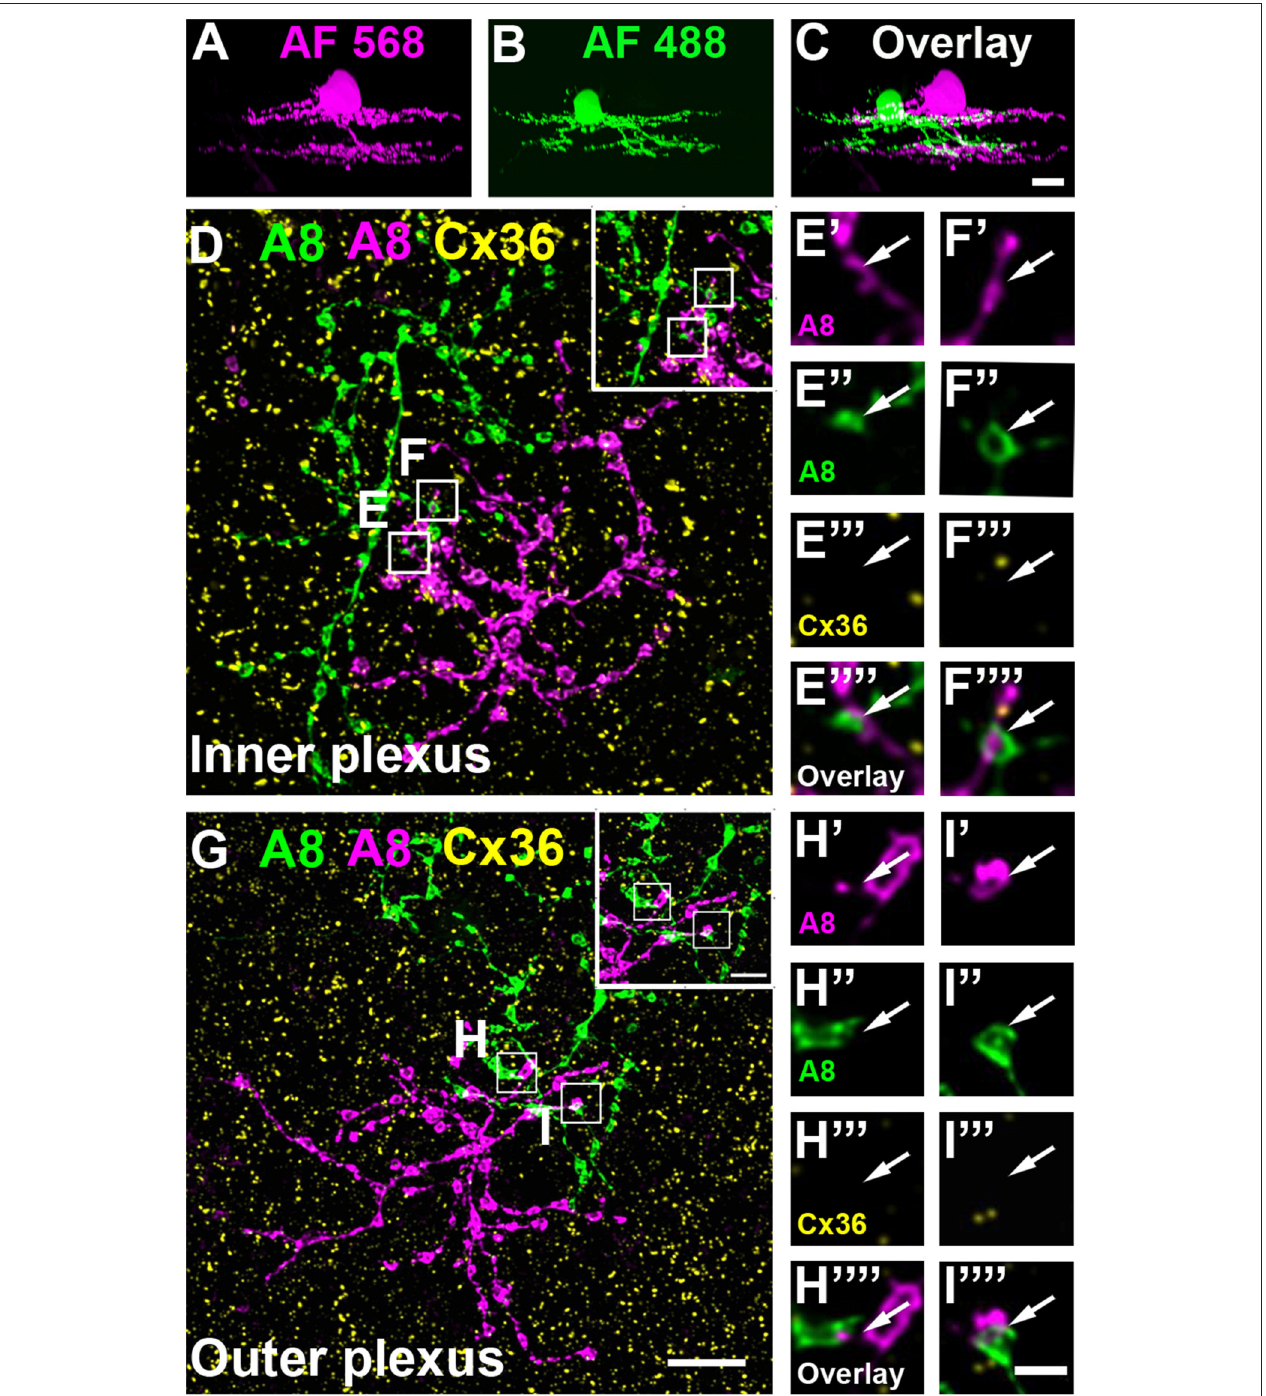
FIGURE 3 | A8 amacrine cells do not contact other A8 cells via Cx36. (A–C) XZ rotation of two A8 cells injected with Alexa Fluor 568 (A) and 488 (B) with overlapping dendrites (C) . (D–I””) Maximum projection of inner (D) and outer plexus (G) of the A8 cell pair, stained for Cx36. Insets show enlarged maximum projections of regions with A8-A8 contacts. Boxes denote the magnified regions of interest from the inner (E,F) and outer plexus (H,I) as shown in (E’–F”’) and (H’–I””) . No Cx36 labeling was detected at A8-A8 contact points (arrows). Similar results were obtained for three other A8 cell pairs. Scale bar: (A–D,G) , 10 µ m; insets in (D,G) , 5 µ m; (E’–F””) ; (H’–I””) , 2 µ